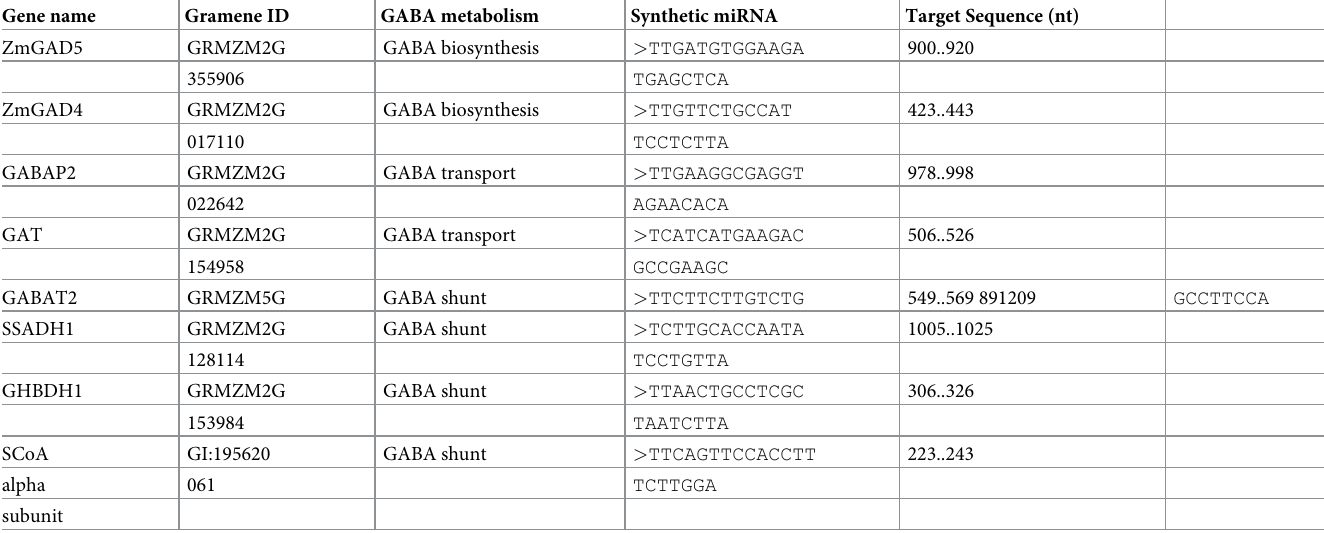
Table 1. List of corn GABA metabolic pathway gene transformants and their targeted for suppression using synthetic miRNA. Gene